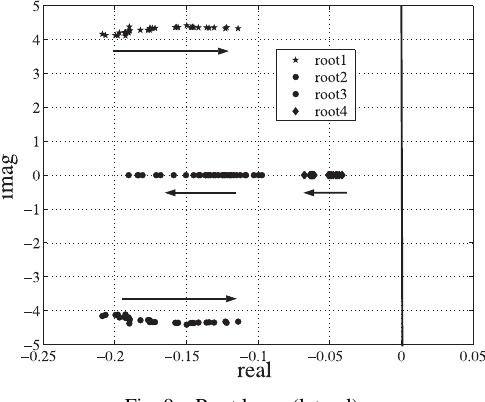
Fig. 9 Root locus